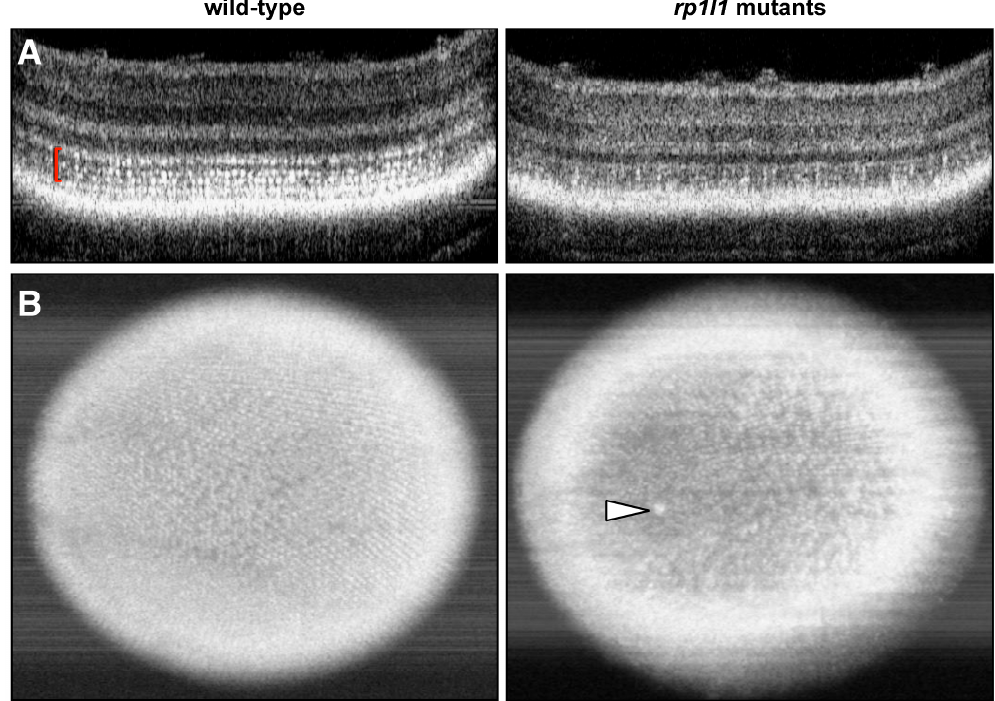
Figure 5. rp1l1 mutant zebrafish have fewer hyper-reflective inner segment punctae and gaps in the photoreceptor mosaic. Optical coherence tomography (OCT) of wild-type and rp1l1 mutant zebrafish retinas at 12 months. ( A ) OCT B-scans through zebrafish retinas. In the wild-type animals, the photoreceptor inner segments (seen as hyper-reflective dots, red brackets) are abundant and uniformly distributed. In mutant animals, this part of the retina is very patchy and appears to have fewer punctae. ( B ) En face projections through the retina. In the mutant animals, the mosaic appears patchy and disrupted. There is also a large hyper-reflective speck in the retina of the mutant animal (arrowhead), which typically indicates an immune cell